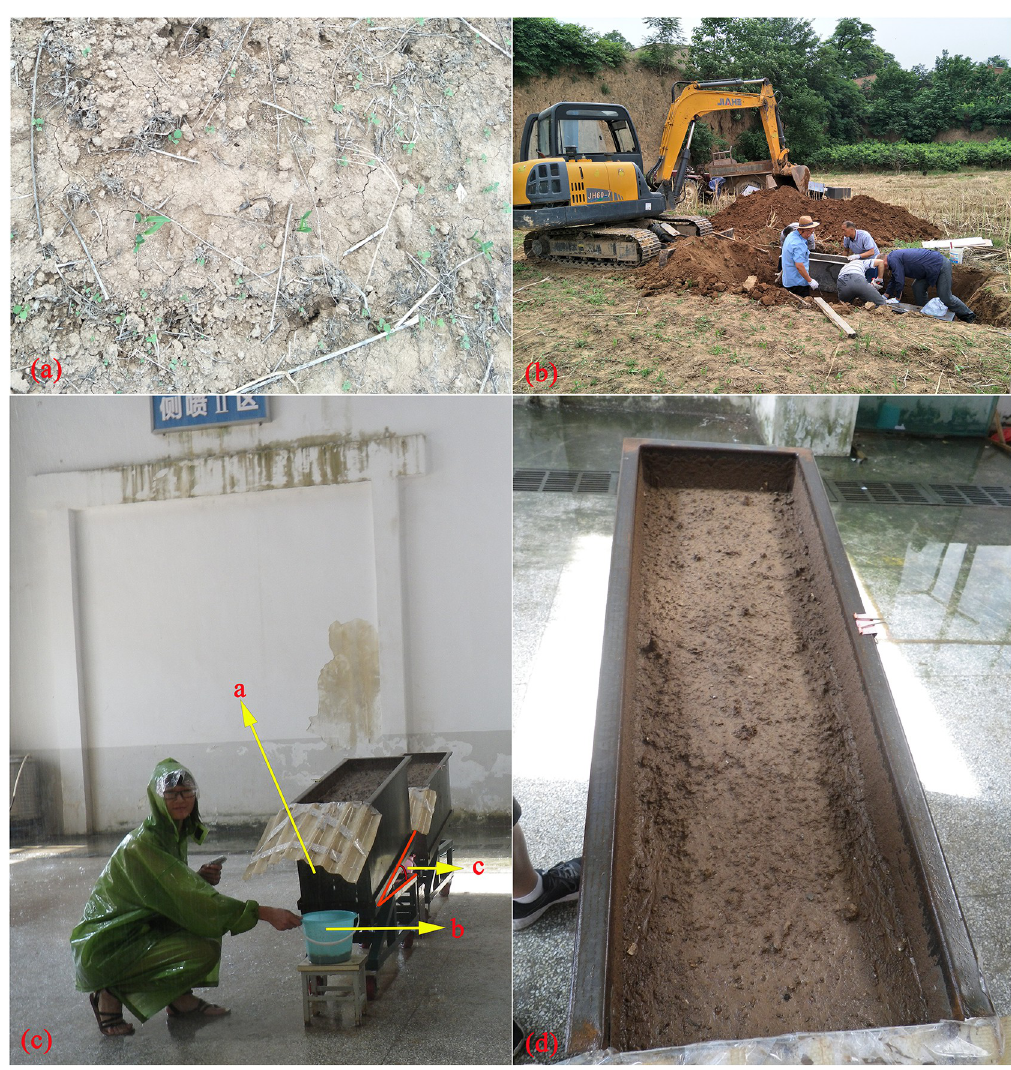
Fig 1. The sampling site ((a) and (b)) and experimental plot ((c); a, outlet for collecting runoff; b, sample bucket to collect samples and c, slope) and soil surface suffering rain-induced soil erosion